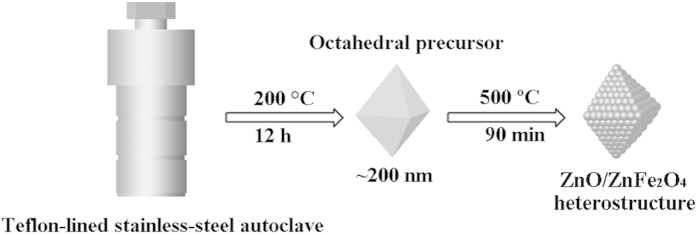
Schematic illustration for the preparation process of the Octahedral ZnO/ZnFe2O4 heterostructures.